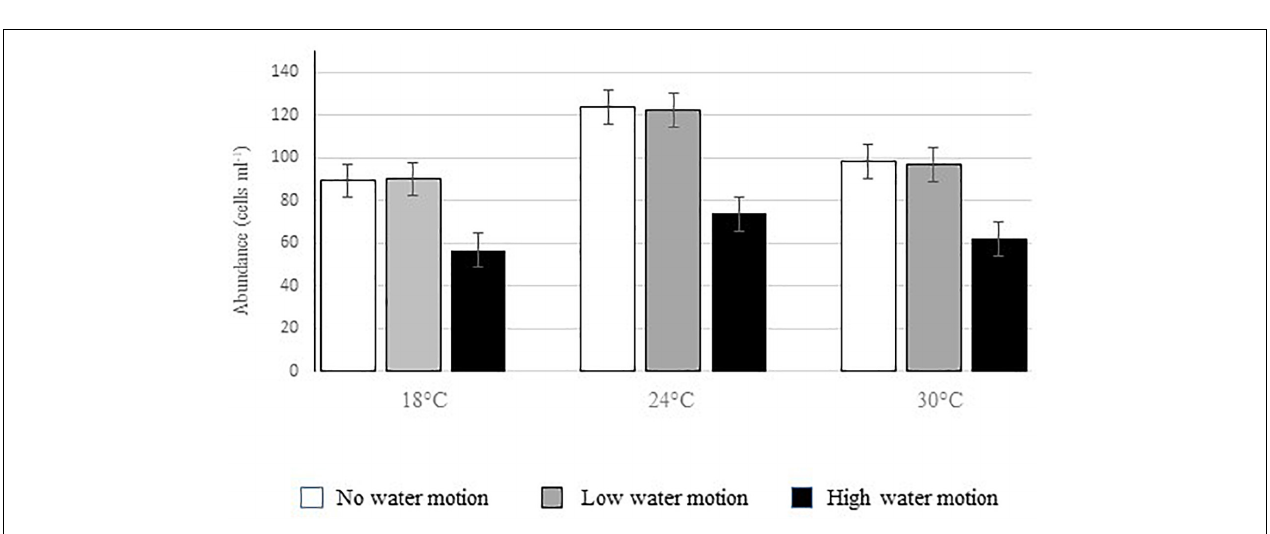
FIGURE 8 | Mean ( ± ES) length (A) and width (B) of the observed gametes in the aquaria with different temperature and water motion treatments.